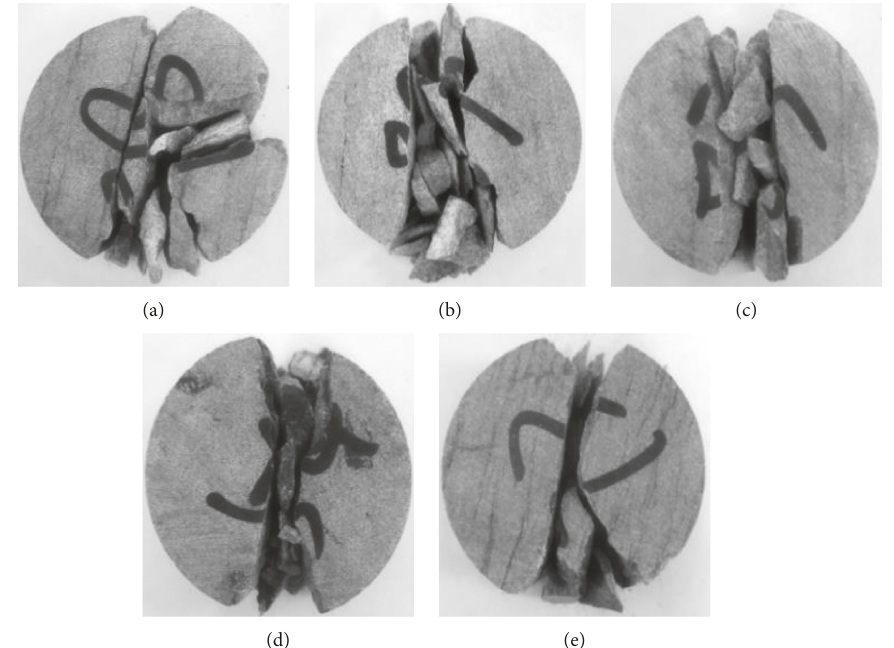
Figure 10: Failure of specimens with different water contents at a strain rate of 89.04 s − 1 : (a) ω � 0.31%; (b) ω � 0.54%; (c) ω � 0.71%; (d) ω � 0.93%; (e) ω � 1.09%.